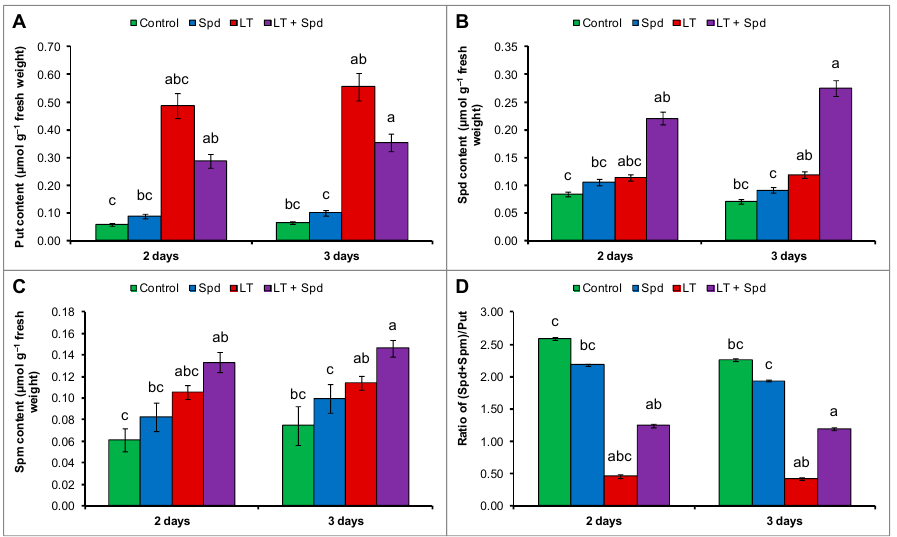
Figure 8. Endogenous putrescine (Put) content ( A ); spermidine (Spd) content ( B ); spermine (Spm) content ( C ) and the ratio of (Spd + Spm)/Put ( D ) in mung bean seedlings. Spd and LT indicate exogenously applied spermidine (0.25 mM) and low temperature (6 °C), respectively. Mean (±SD) was calculated from three replicates for each treatment. Bars with different letters are significantly different at p ≤ 0.05 applying DMRT.